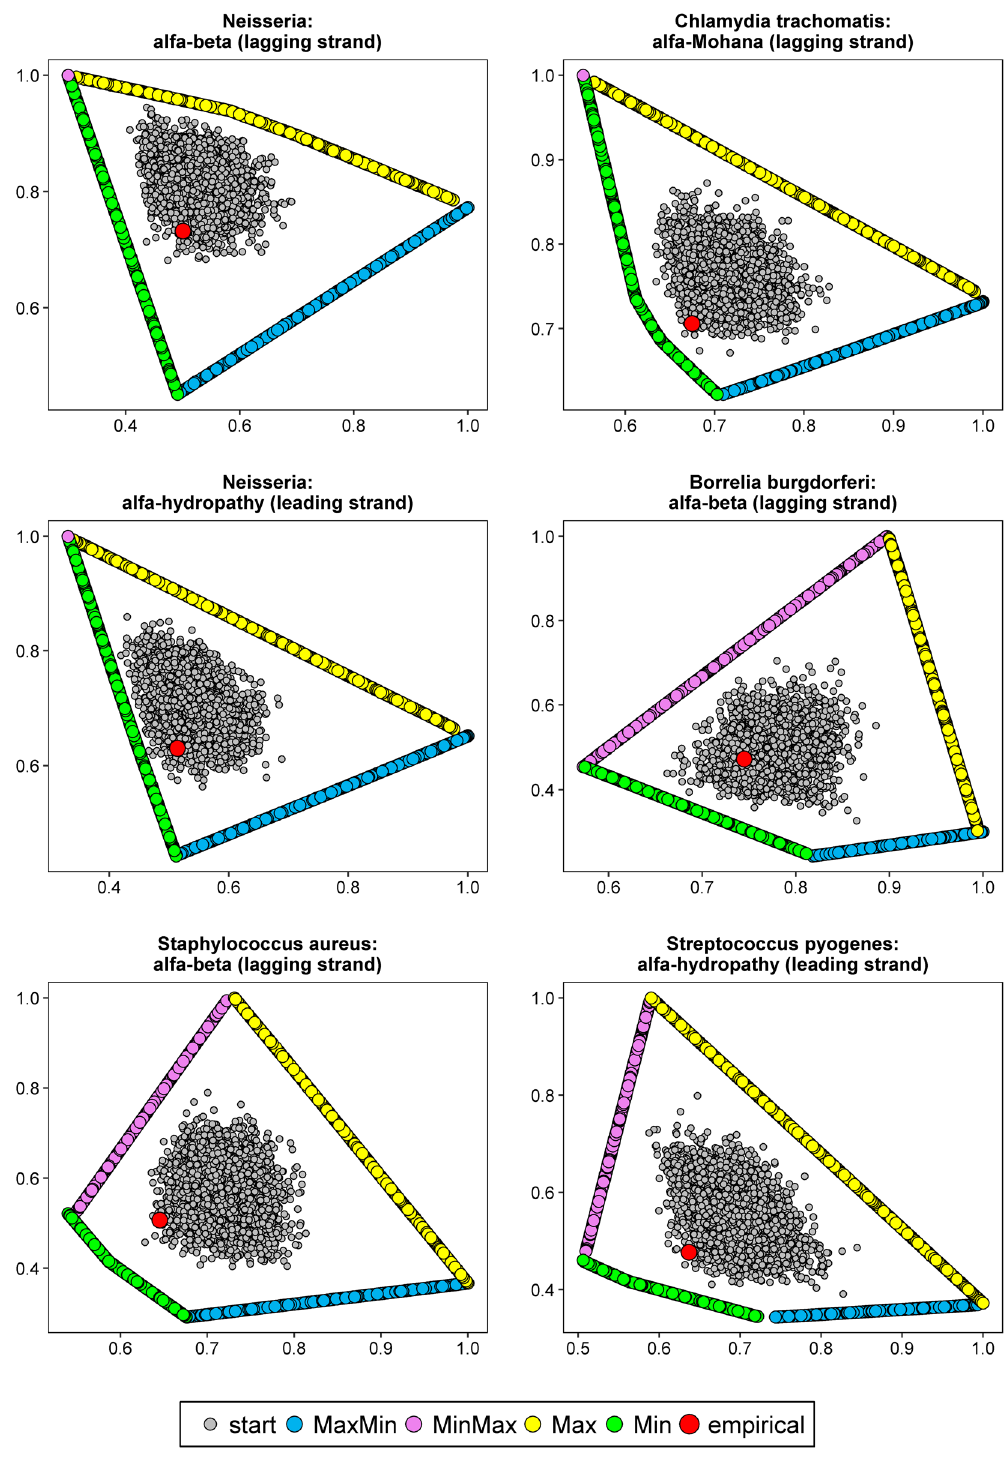
Figure 6. As in Fig.